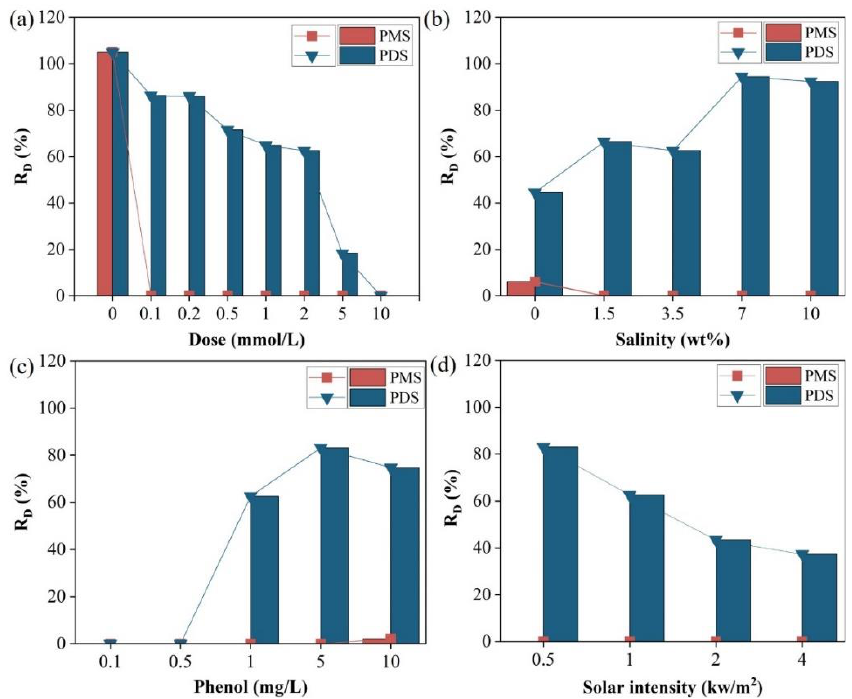
Figure 4. Effects of ( a ) PS dose, ( b ) salinity, ( c ) initial phenol concentration, and ( d ) solar intensity on the R D values of phenol. Experimental conditions: [Phenol] 0 = 1 mg/L, solar intensity = 1 kW/m 2 , [salinity] = 3.5 wt% NaCl, [PMS] = 2 mmol/L, [PDS] = 2 mmol/L.